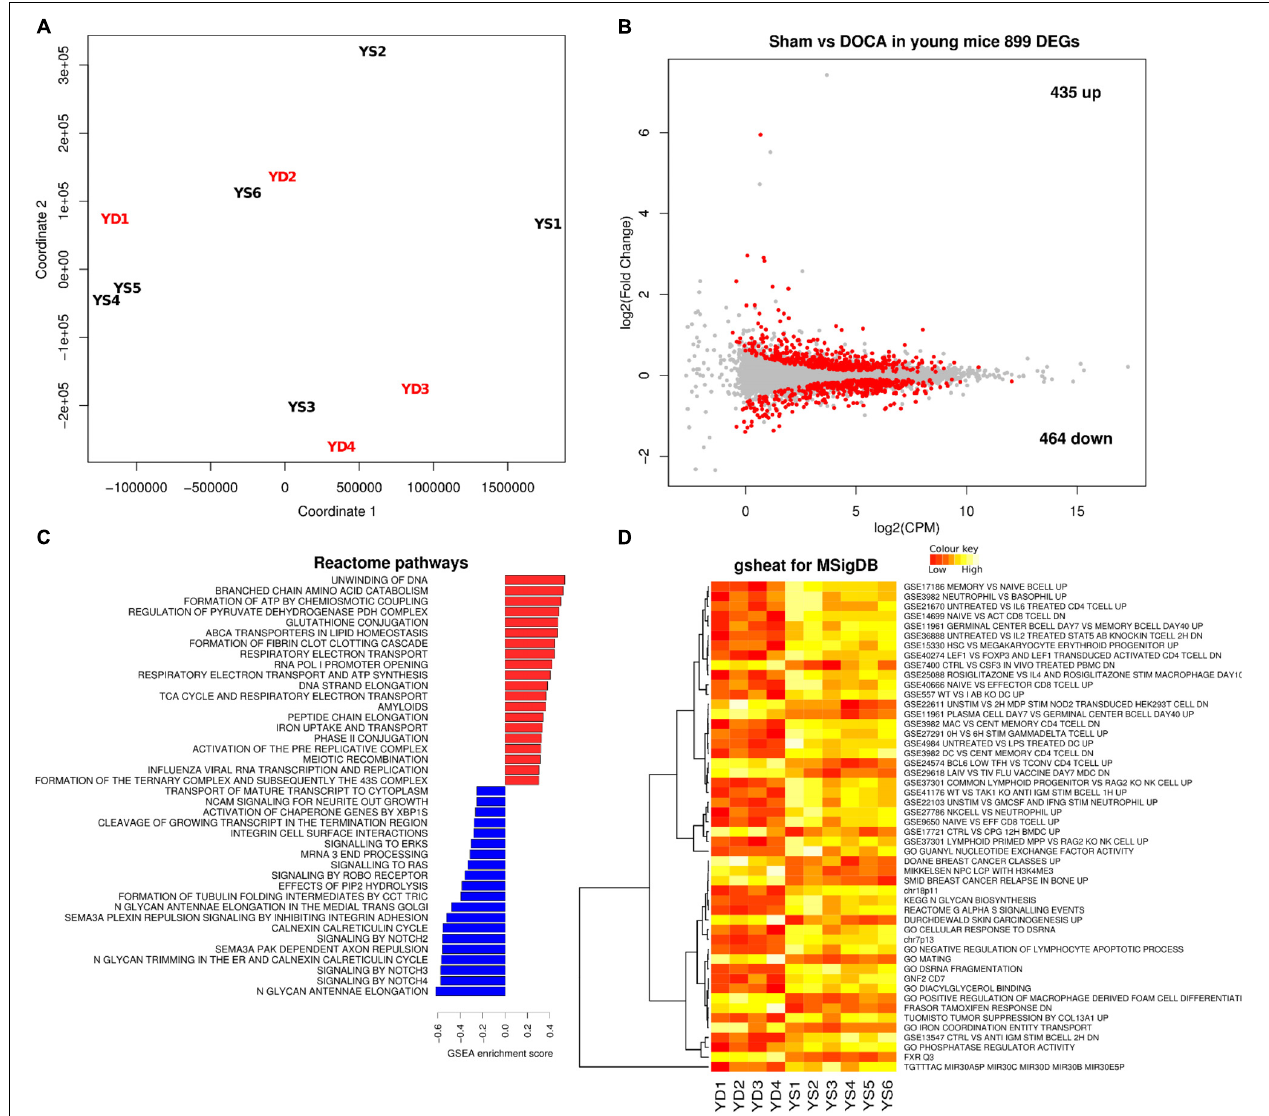
FIGURE 3 | Cardiac transcriptome in young sham vs. DOCA mice. (A) Principal component analyses shows lack of sample group clustering on the first two dimensions for young sham vs. DOCA mice. (B) MA plot showing 899 differentially expressed genes (FDR < 0.05; Supplementary Table S3). Mechanisms differentially regulated between young sham and DOCA mice in the (C) GSEA analysis of Reactome Database and (D) Gsheat analysis of Molecular Signatures Database (MSigDB) (Supplementary Table S4). Sample size: n = 6 young sham vs. n = 4 young DOCA mice. CPM, counts per million; YD, young DOCA; YS, young